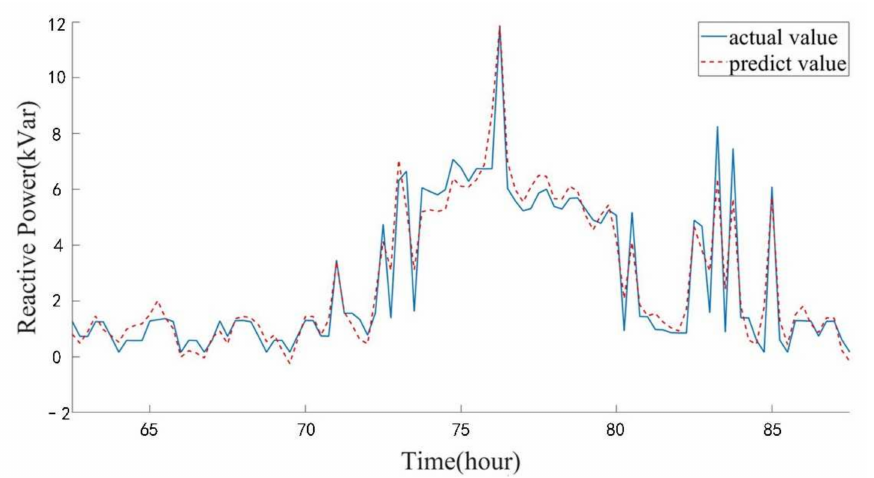
Figure 8. Forecasting results of EEMD-LSTM-RFR.